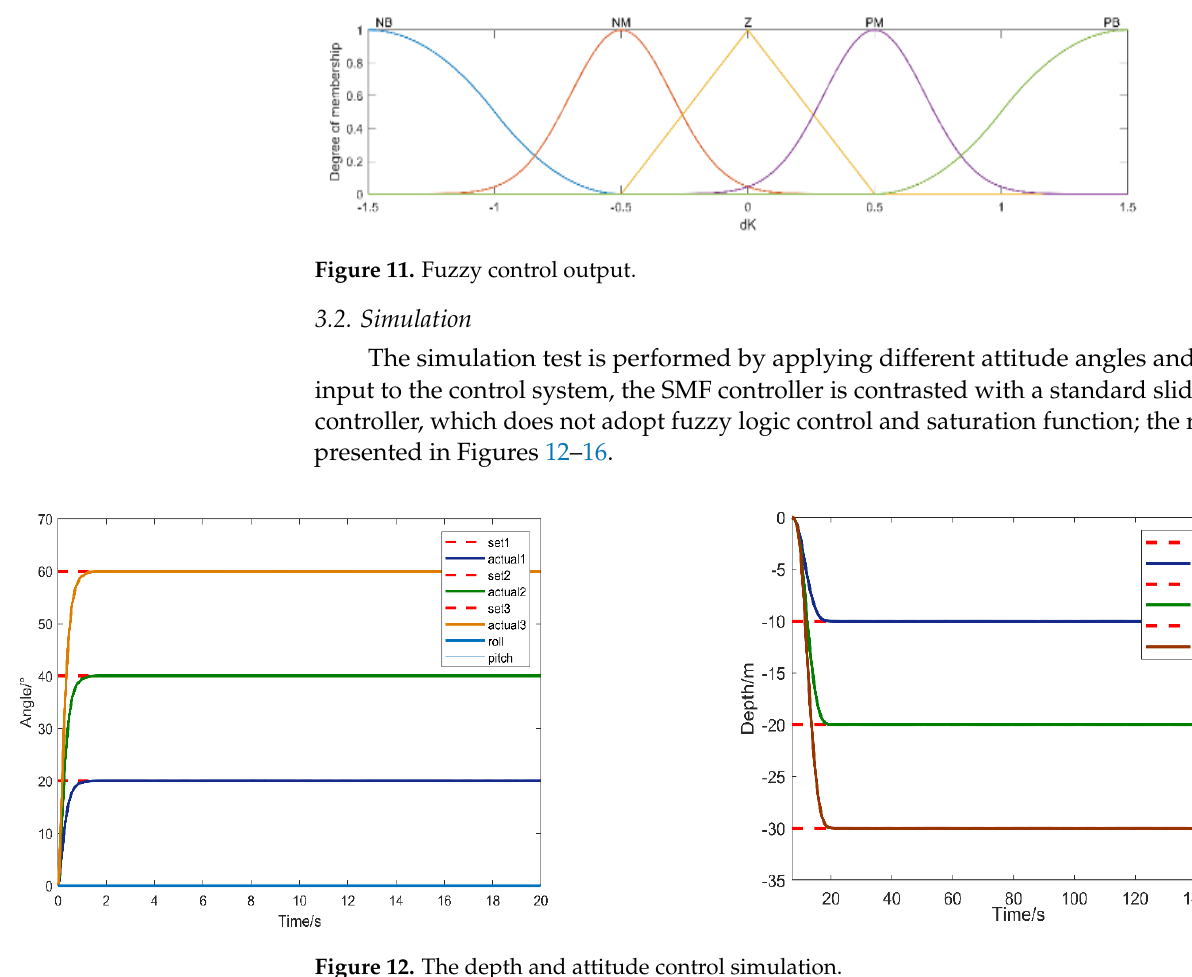
Figure 10. Fuzzy control input.